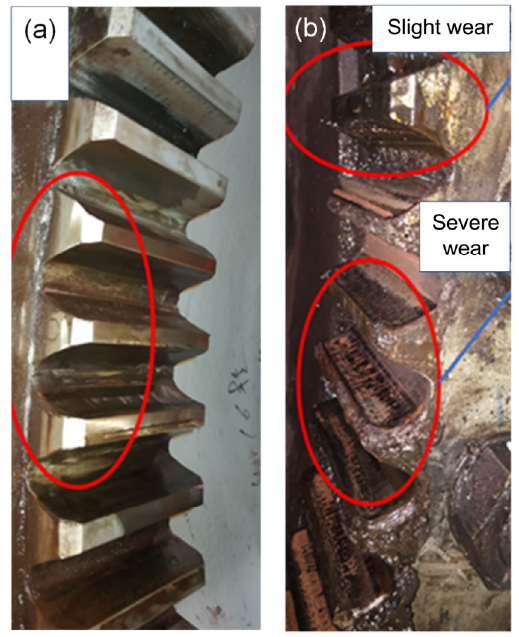
Fig. 17 Wear of gears in a wind